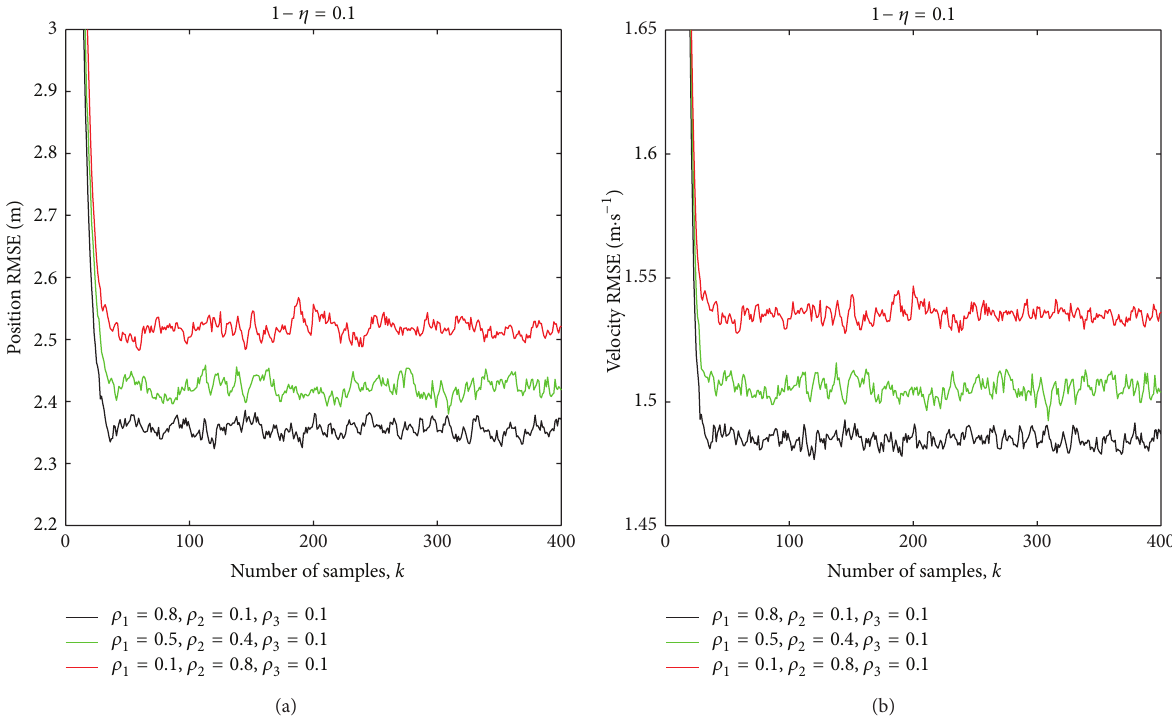
Figure 3: Comparison of the RMSEs for the proposed algorithm with different 𝜌 𝑞 (𝑞 = 1, 2,3) : (a) position RMSE; (b) velocity